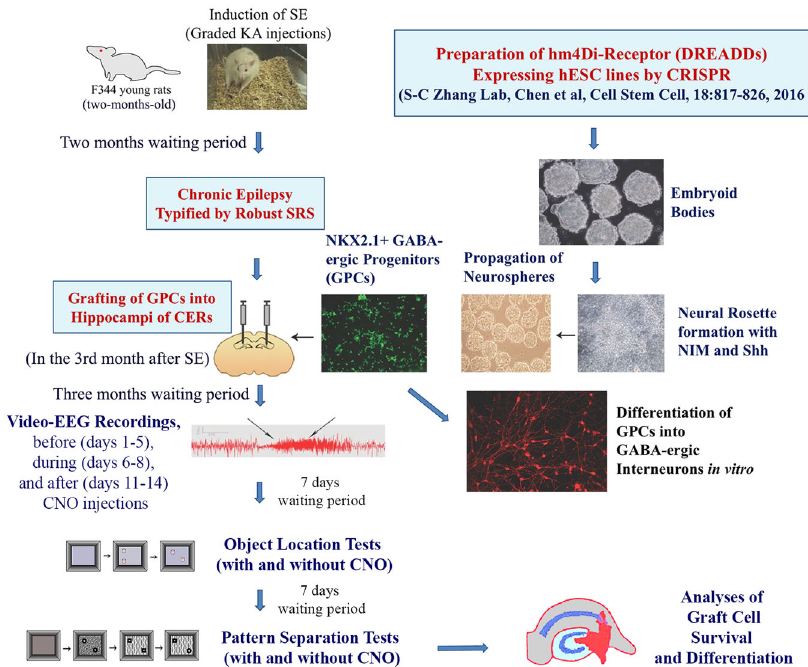
Fig. 1 The overall experimental design and the sequence of experiments performed in the study. Status epilepticus (SE) was induced in two-month-old male F344 rats through graded kainic acid injections. Two months later, animals exhibiting chronic temporal lobe epilepsy (TLE) typi fi ed by spontaneous recurrent seizures (SRS) were chosen for bilateral grafting of human medial ganglionic eminence (hMGE)-like cells. The hMGE cells were generated from hM4Di-receptor (a designer receptor activated only by designer drugs, DREADDs) expressing human embryonic stem cell (hESC)-line through a directed differentiation protocol. In the fourth month after grafting, rats were implanted with electrodes, and 2 weeks later, continuous video-encephalographic (video-EEG) recordings were taken before (days 1 – 5), during (days 6 – 8), and 2 days after (days 11 – 14) clozapine- N -oxide (CNO) treatment. Seven days after completing video-EEG recordings, the animals were probed with the object location tests (OLTs), with and without CNO administration, to assess hippocampus-dependent cognitive function. Seven days after completing the second OLT, the animals were investigated with the pattern separation tests (PSTs), with and without CNO administration, to examine their pattern separation ability. Following behavioral tests, the animals were perfused, and fi xed brain tissues were processed to analyze the differentiation and integration of graft-derived cells through dual and triple immuno fl uorescence methods and confocal